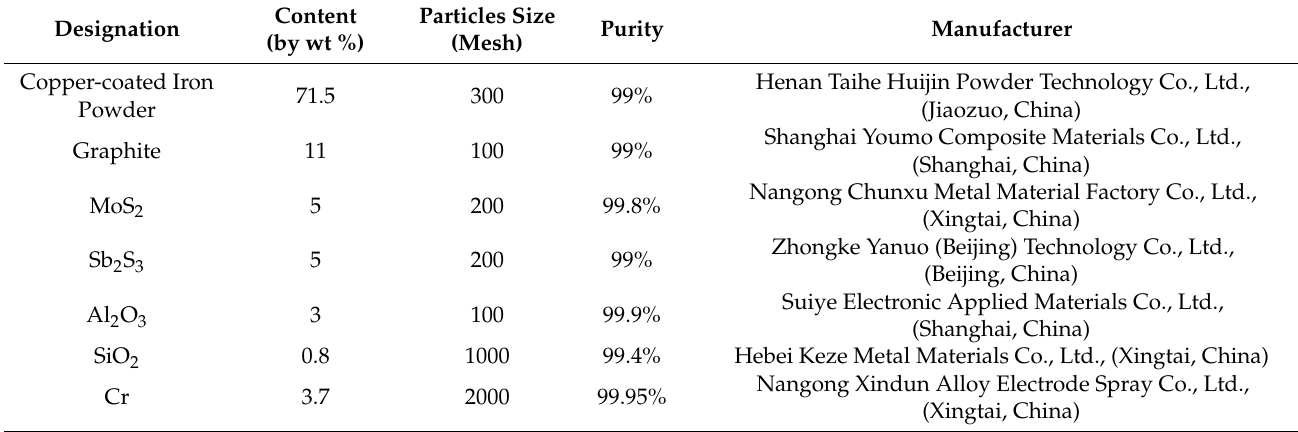
Table 1. The experimental